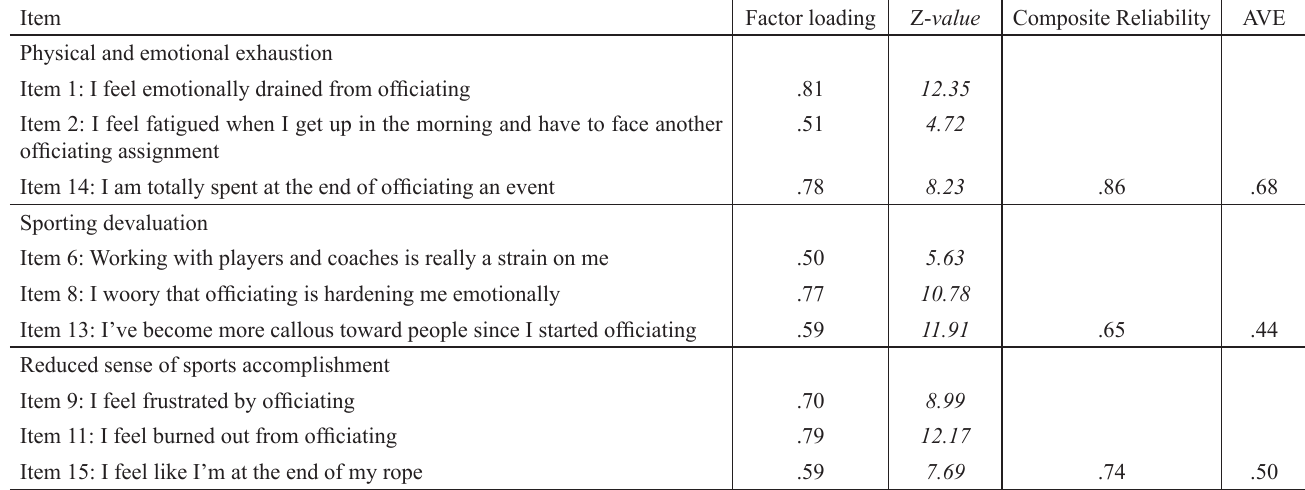
Table 1. Factor loadings, Z -values, composite reliability, and Average Variance Extracted (AVE) for the first-order